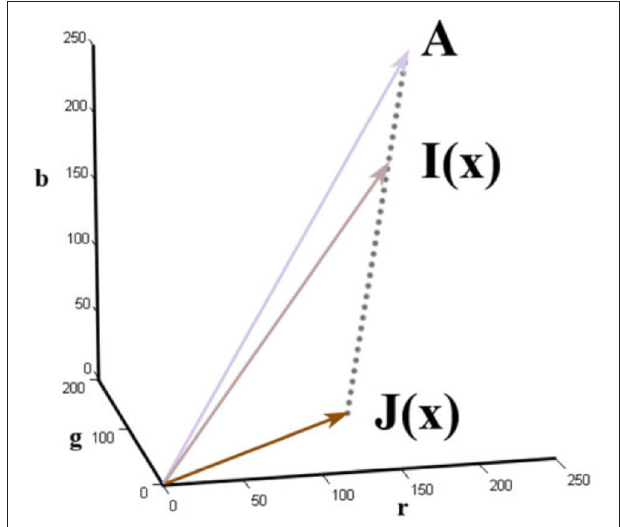
FIGURE 1 | The image formation model used in dehazing, taken from He et al. (2011)